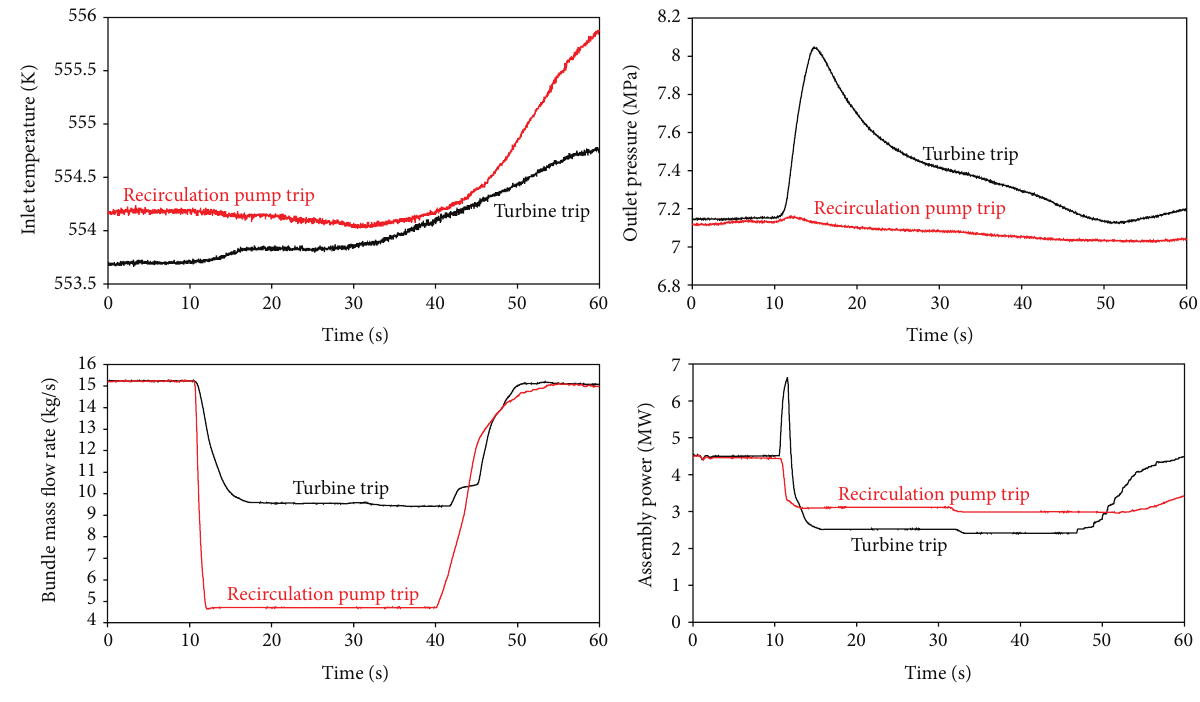
Figure 1: Input and boundary conditions during the transients.